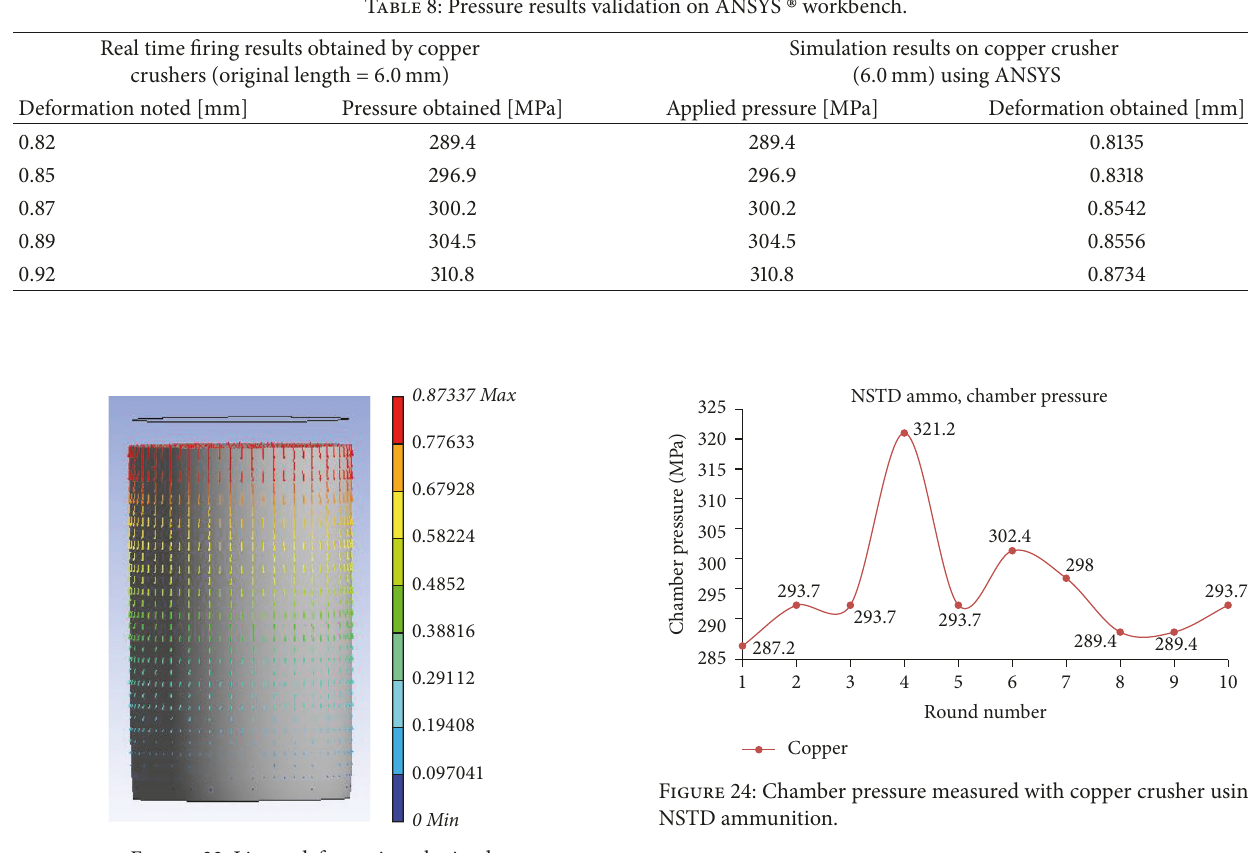
Figure 22: Linear deformation obtained.